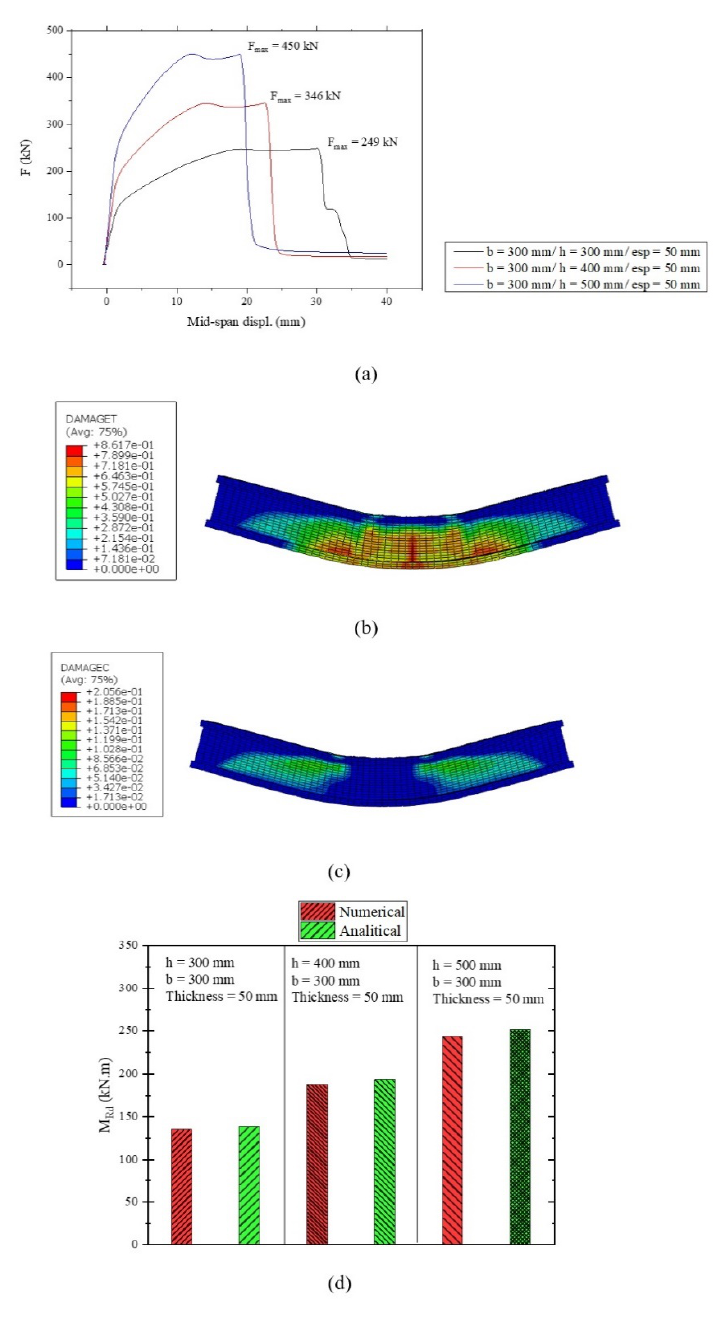
Figure 9. Prestressed I-Girder – Parametrical analysis: (a) Force-displacement, (b) tensile damage, (c) Compressive damage, (d) Comparison of bending